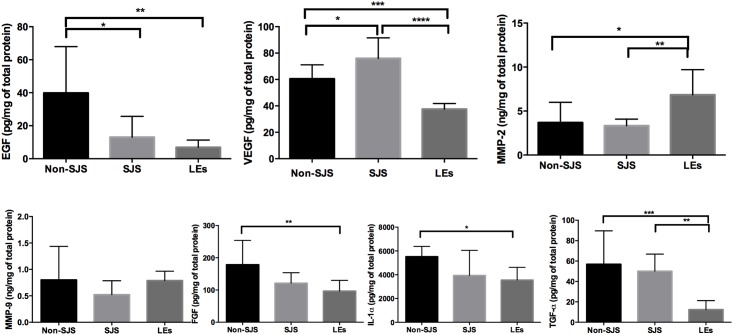
Cytokine profiles of the oral mucosal epithelial cells from Stevens—Johnson syndrome (SJS) and non-SJS subjects.ELISA assay showed that the level of VEGF was higher, and the level of EGF was lower in the cells from SJS oral mucosa (SJS) than those in the cells from normal oral mucosa (non-SJS). When compared to the expression of cytokine/growth factors in limbal epithelial cells (LEs), the level of VEGF and TFG-α were higher, while the level of MMP2 was lower in mucosal epithelial cells regardless of SJS status. The levels of FGF, EGF, and IL-1α were higher in non-SJS mucosal cells than in LEs. All data represent the mean ± standard deviation. (*p<0.05, **p<0.01, ***p<0.001, ****p<0.0001, One-way ANOVA)